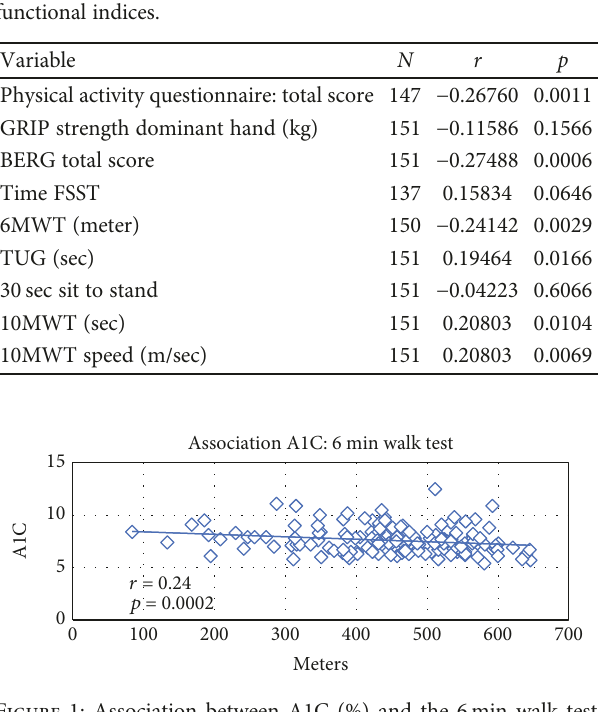
Figure 1: Association between A1C (%) and the 6min walk test distance (meter).